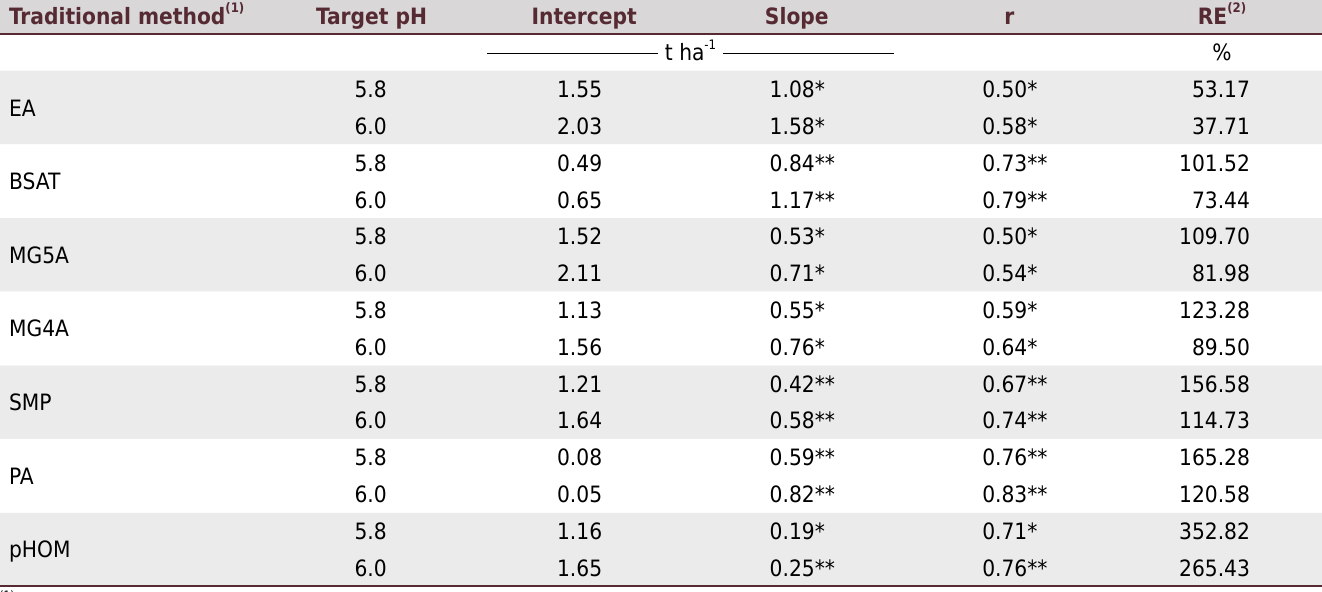
Table 4. Regression parameters of the relationships between lime requirement (LR) determined from the standard incubation method to raise soil pH to target values of 5.8 and 6.0 (ŷ, t ha -1 ) and LR determined by traditional methods (x, t ha -1 ), as well as the corresponded relative efficiency (RE) of each prediction method Traditional method (1)